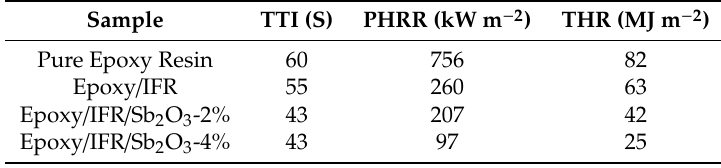
Table 6. Cone calorimeter results of the coatings.